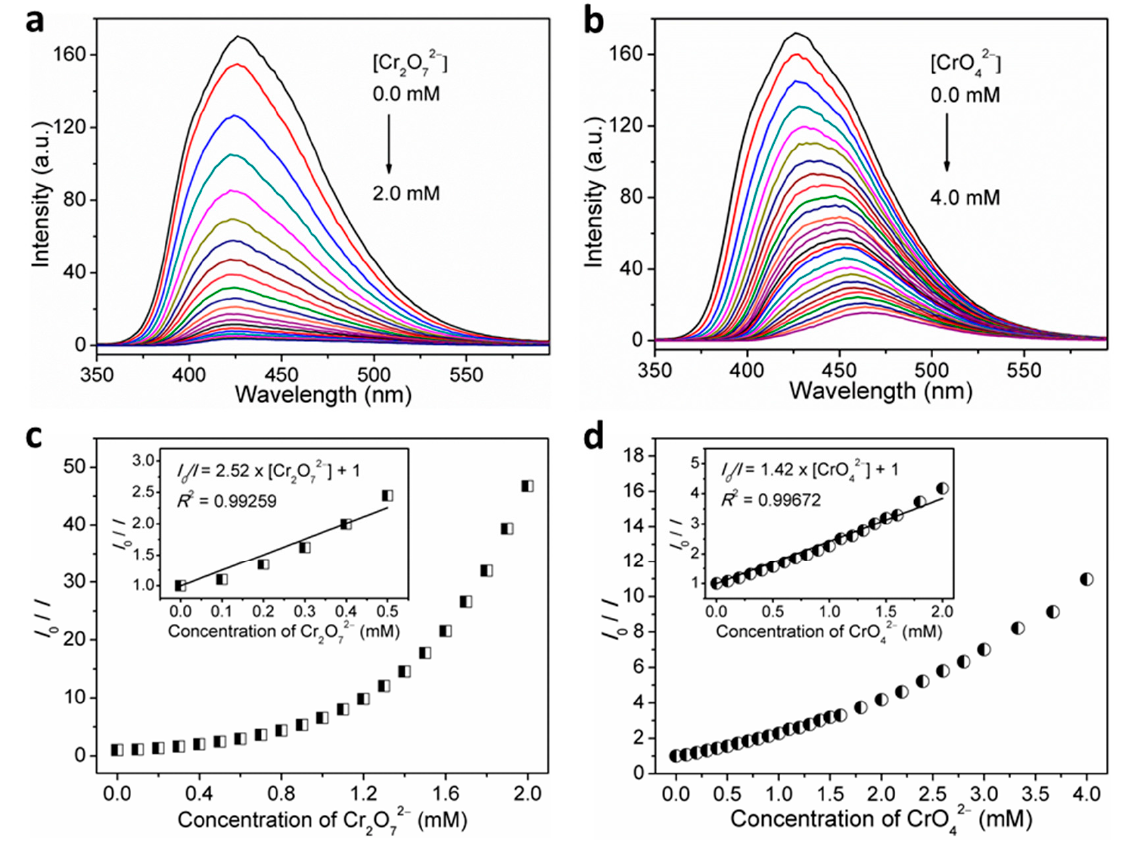
Figure 9. Concentration-dependent fluorescence spectra of 1 in H 2 O suspensions by incremental addition of ( a ) Cr 2 O 72 − , and; ( b ) CrO 42 − upon excitation at λ ex = 306 nm, and Stern–Volmer plot of I 0 / I versus concentration of; ( c ) Cr 2 O 72 − , and; ( d ) CrO 42 − for 1 in H 2 O suspensions (inset: linear Stern–Volmer plot).